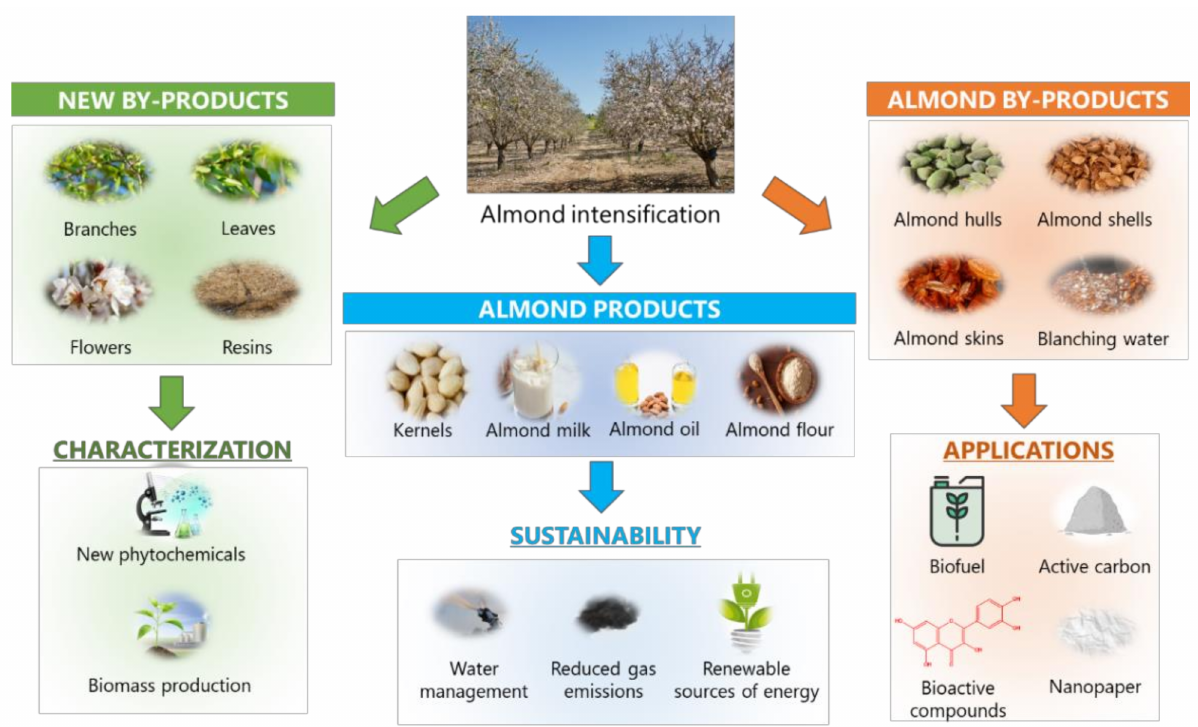
Figure 3. Future perspectives regarding the valorization of almond products and